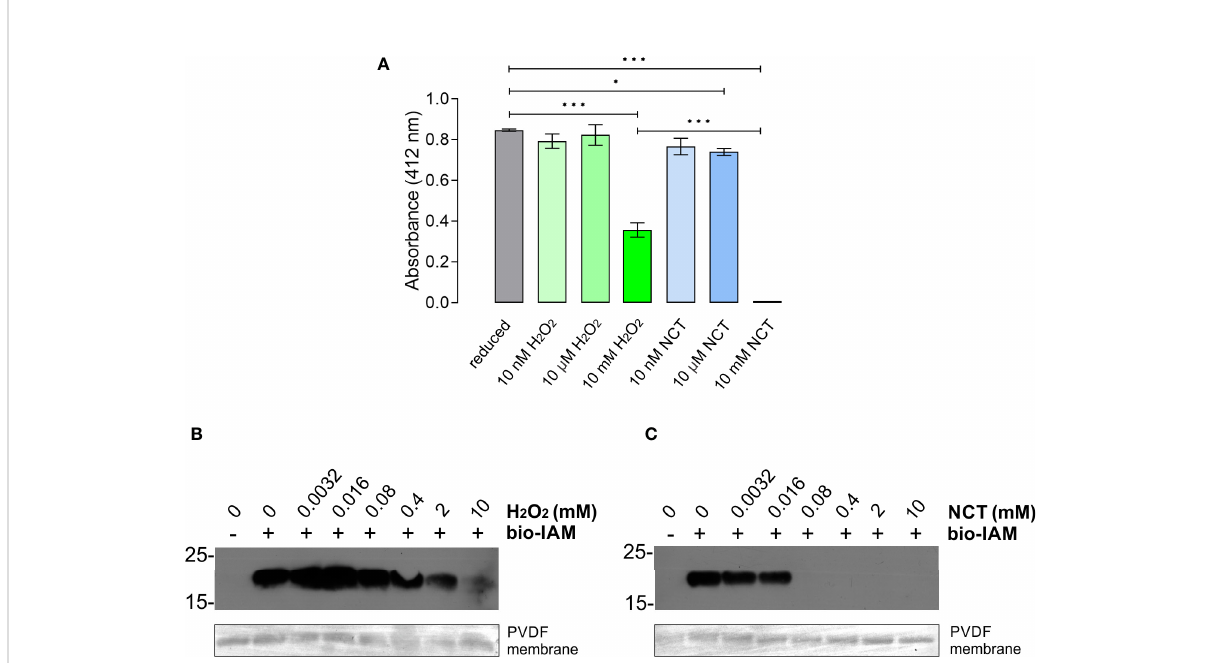
FIGURE 2 Oxidation of NcADF cysteine residues. Recombinant NcADF was reduced with TCEP. After removing TCEP, the protein was oxidized with NCT or H 2 O 2 . (A) NcADF was incubated with NCT or H 2 O 2 and the cysteine residues´ oxidation was detected by three independent DTNB assays performed in duplicate. The bars represent the mean ± SD. The *** indicates p ≤ 0.0001 and the * indicates p ≤ 0.05 in Tukey ’ s test between the treatments. (B, C) NcADF was incubated with 0-10 mM H 2 O 2 (B) or NCT and 25 µM NcADF in 20 µl non-reductant sample buffer was loaded in the gel (C) . The oxidants were inactivated with catalase or histidine/methionine, respectively, and alkylated with 0,5 µM bio-IAM.